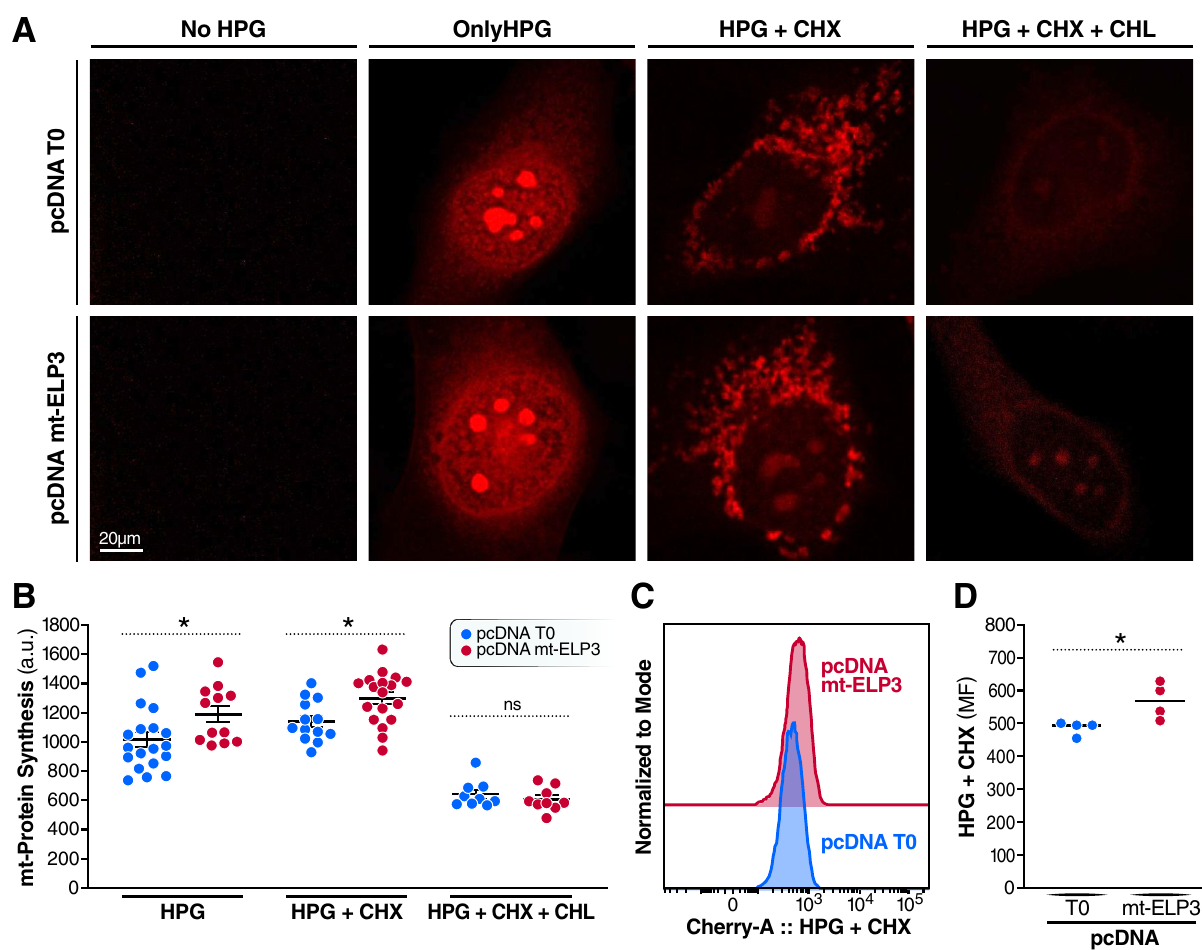
Figure 4. Overexpression of mt-ELP3 results in an increase in mitochondrial translation. ( A ), ( B ) , ( C ) and ( D ) Evaluation of mitochondrial translation. De novo mitochondrial protein synthesis was visualized in HEK293T cells transiently transfected with empty plasmid (pcDNA T0) or mt-ELP3 plasmid (pcDNA mt-ELP3) by incubation with or without HPG (1 h) and with or without cycloheximide (CHX) and/or chloramphenicol (CHL). After 1 h, the cells were fixed, underwent the click reaction and analyzed for the flurorescence-tagged HPG incorporation by flurorescence microscopy ( A ) or flow cytometry ( C ). The HPG signal was calculated and presented graphically ( B, D ). All data are mean ± SD of at least three experiments. * p < 0.05. n.s.: not